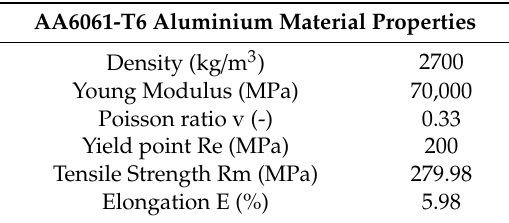
Table 1. Aluminium model